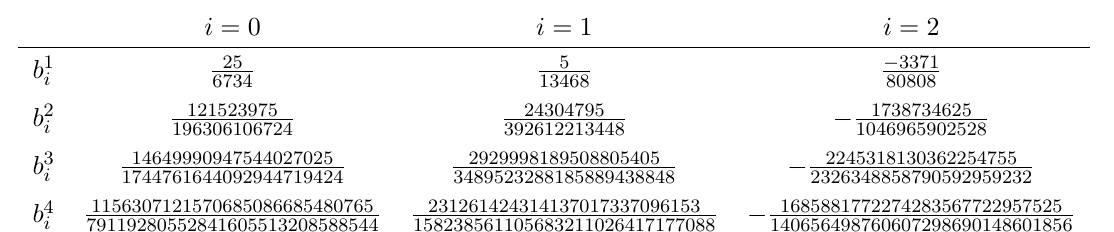
, for u = 0 , m = − 1 / 10 , Λ = 1 i